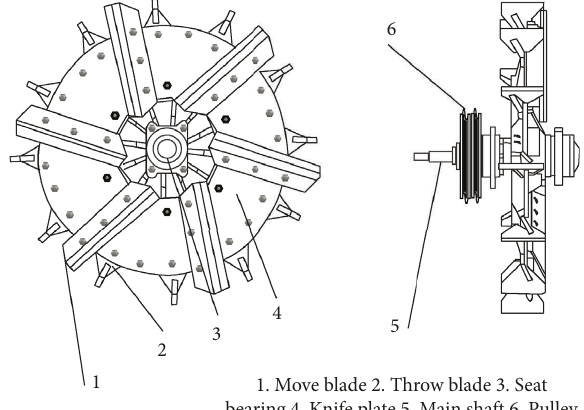
Figure 5: Cutter assembly